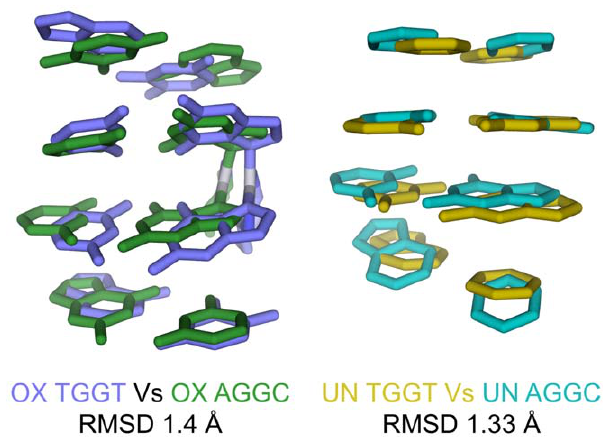
Figure 3. Comparison of OX-GG and undamaged DNA solution structures in the TGGT and AGGC sequence contexts. Structural alignment of OX-DNA in the TGGT and AGGC sequence context (left) and undamaged DNA in the TGGT and AGGC sequence context (right) are displayed using stick representation, generated in PyMOL (www. pymol.org). The DNA atoms common to AGGC and TGGT sequence context was used in the structural alignment of the central four base- pairs.